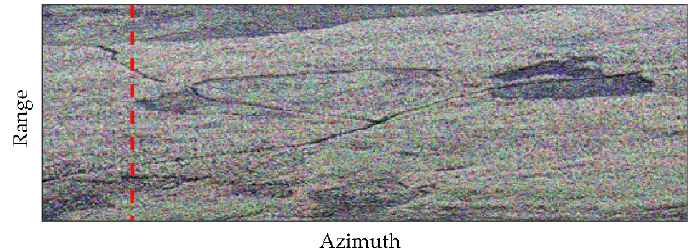
Figure 3. The selected range profile (red dotted line) on the SAR Pauli map.